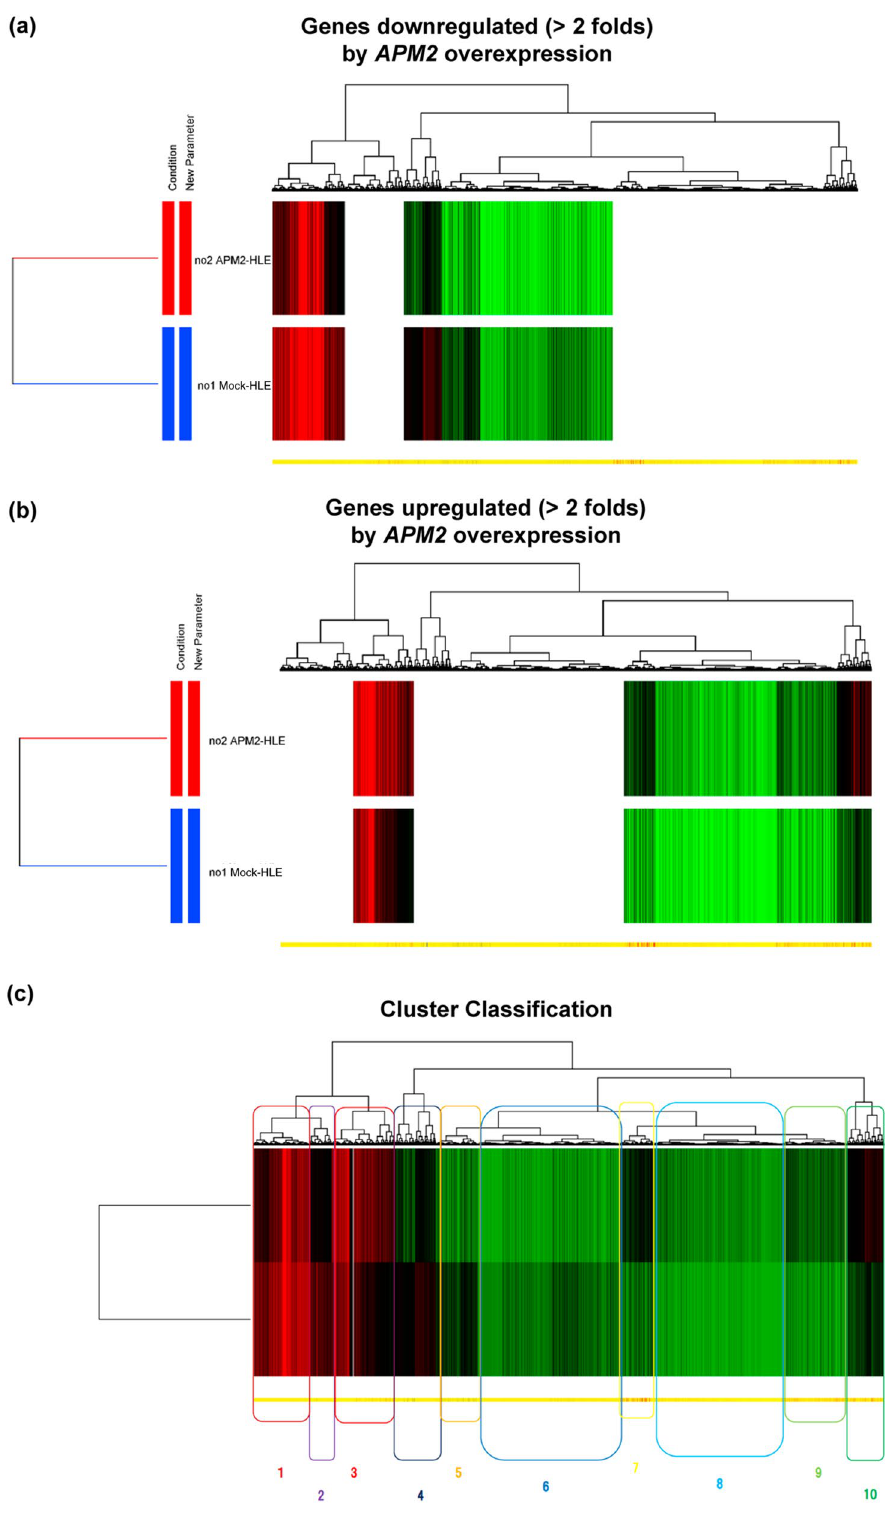
Figure 3. Microarray and bioinformatic analyses. Microarray analyses were performed to compare the levels of gene expression in mock-transfected HLE and APM2-transfected HLE. A total of 6169 genes with more than two-fold differences in the expression were clustered hierarchically according to level of gene expression. ( a ) Downregulated (> 2 folds) and ( b ) upregulated (> 2 folds) genes. The color represents the expression level of the gene: green represents low changes of expression, whereas red represents high changes of expression. The expression levels are continuously mapped on the color scale ( a , 2–247.1-fold change; b , 2–69.2-fold change). ( c , d ) Ten groups were assessed with related gene expressions using gene ontology term analyses. ( e ) Gene expression network analysis based on the microarray assays using the in vitro APM2 overexpressing cell lines (HLE). Inset focuses on the significantly related genes. APM2, adipose most abundant